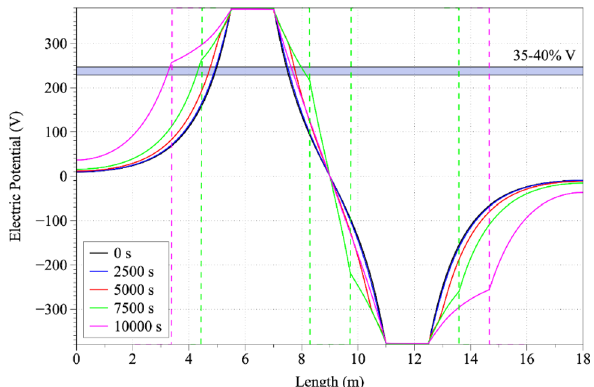
Figure 2. Electric potential distribution across an intercept line from x 1 = 0 to x 2 = 17 m for constant y = 1.7 m.